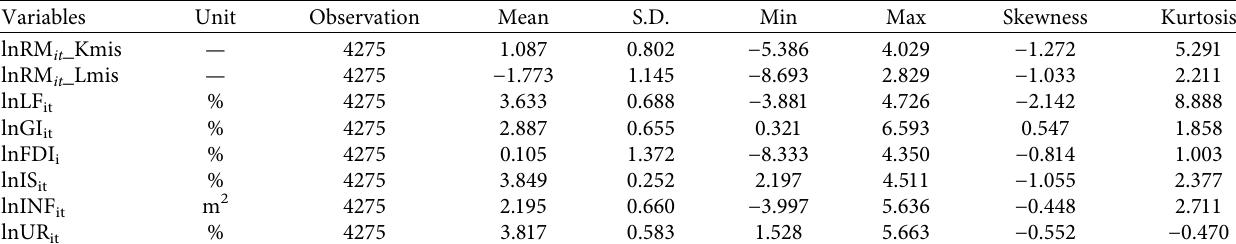
Table 1: Summary